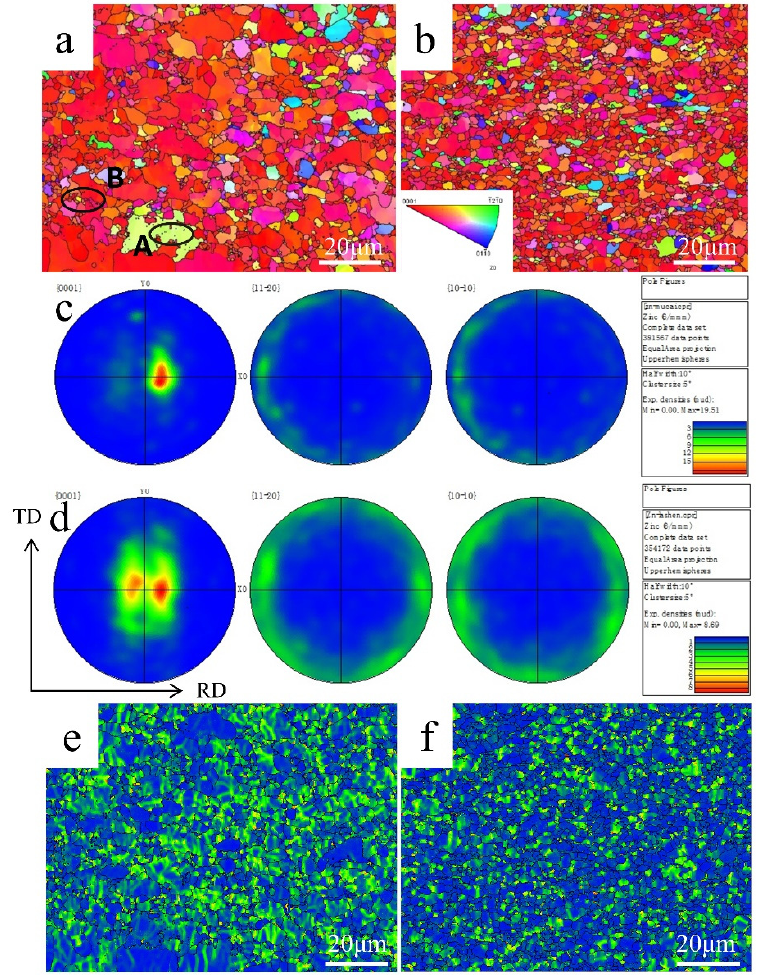
Figure 7. EBSD microstructure of pure Zn: inverse pole figure ( a , b ); pole figure ( c , d ); and kernel average misorientation maps ( e , f ). Rolled ( a , c , e ); stretched ( b , d , f ).